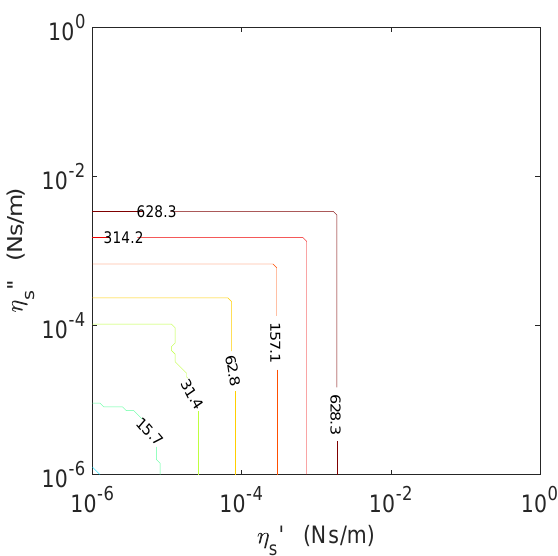
Figure 7. Boundaries separating the regions of the ( η (cid:48) s , η (cid:48)(cid:48) s ) plane where the interface can be distinguished from a clean air–water interface, under the fulfillment of either one of the conditions in Equation (9). Lines at frequencies indicated by the line labels in the frequency range 0.63 ≤ ω ≤ 628.32